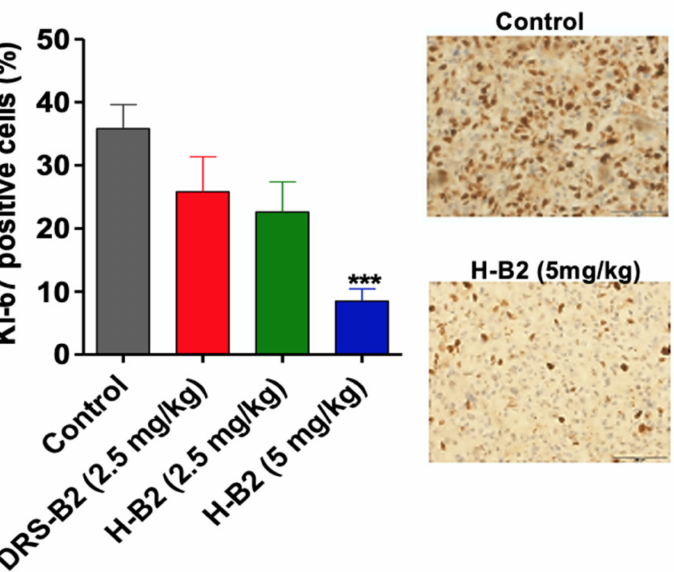
Figure 5. Effect of DRS-B2 and H-B2 on tumor proliferation in vivo. PC3 tumor proliferation was evaluated by Ki67 staining of frozen tissue sections. Proliferation was quantified by image J software analysis of Ki67 positive stained cells on the whole tumor section. The data are mean areas ± SEM, p < 0.001 (***). Representative tumor section, scale bar, 50 µ